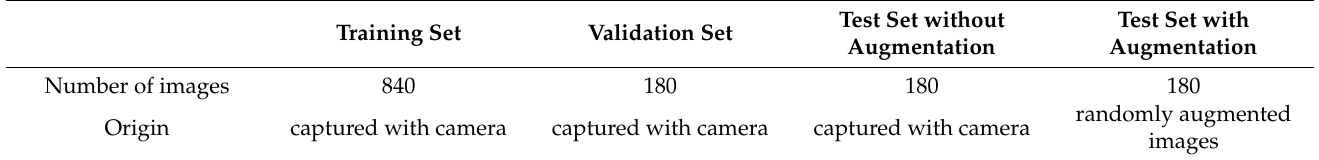
Table 2. Image sets